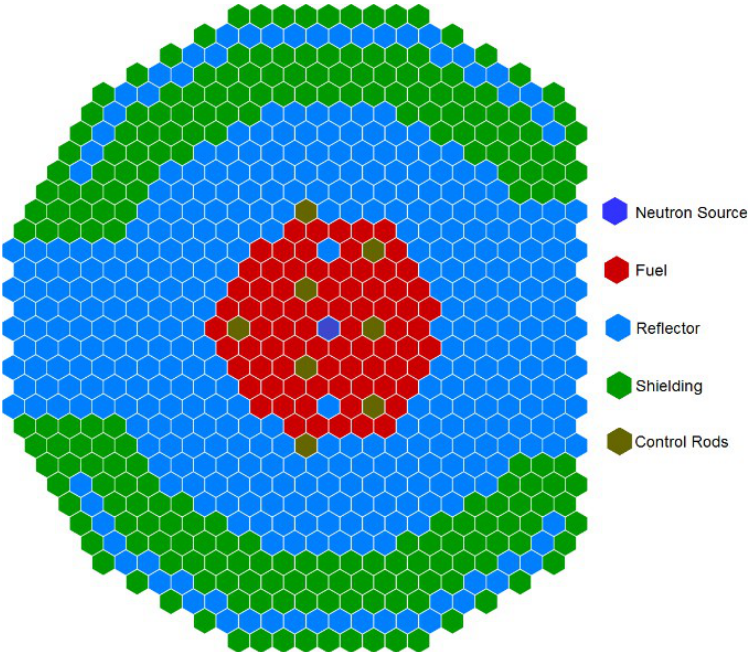
Figure 1. CEFR Core